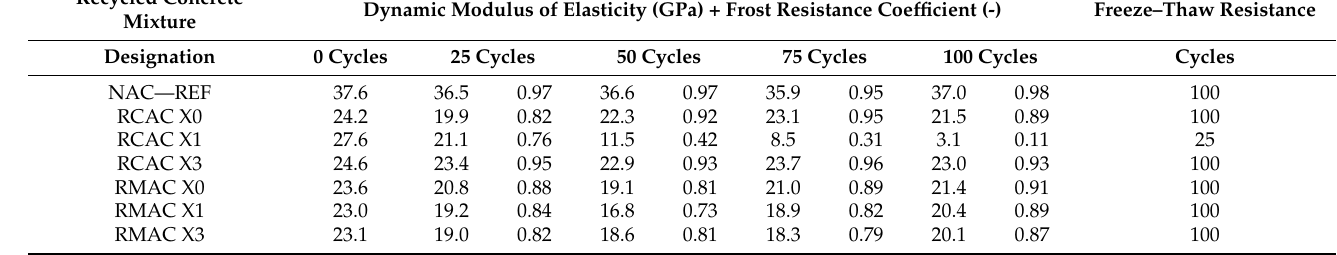
Table 6. Dynamic modulus of elasticity measured by ultrasonic method and frost resistance coefficient determined from the dynamic modulus of elasticity after freezing and thawing cycles.